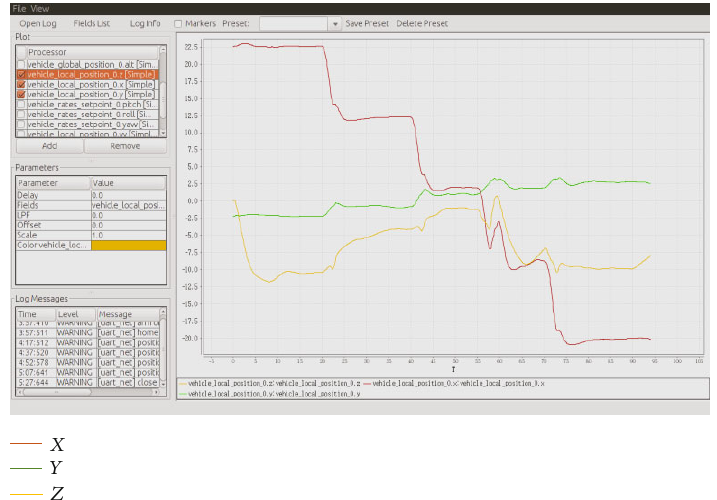
Figure 17: Displacement of UAV.